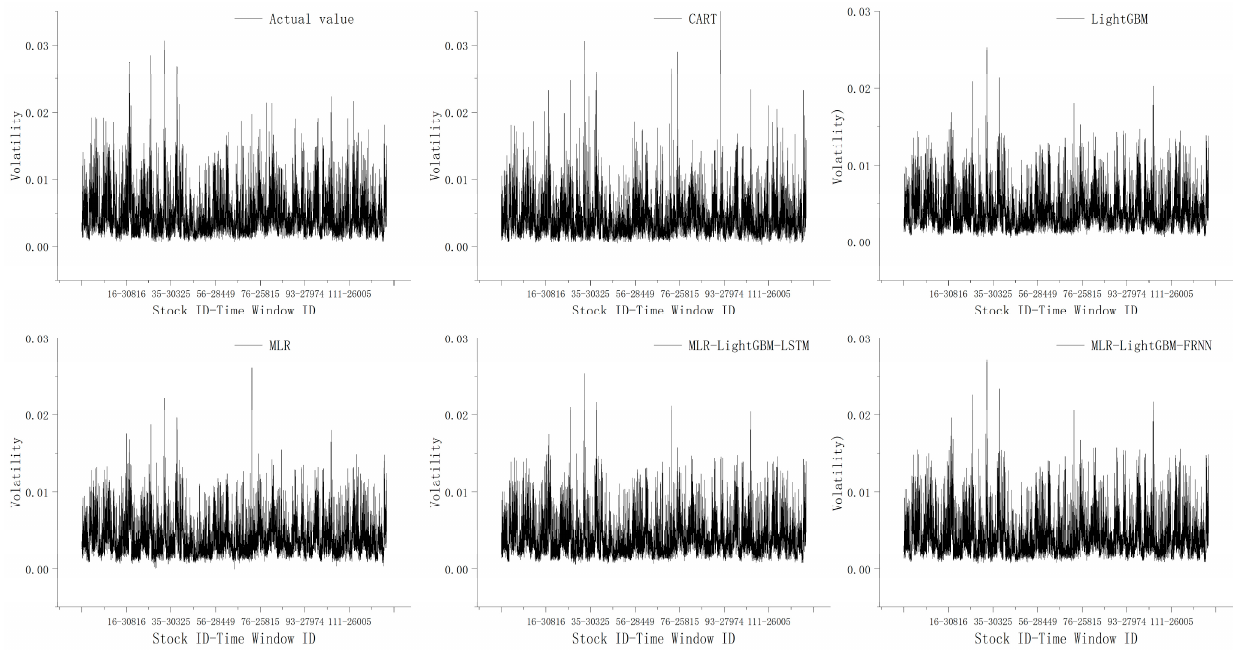
Figure 18. Comparison of prediction results for the test set.